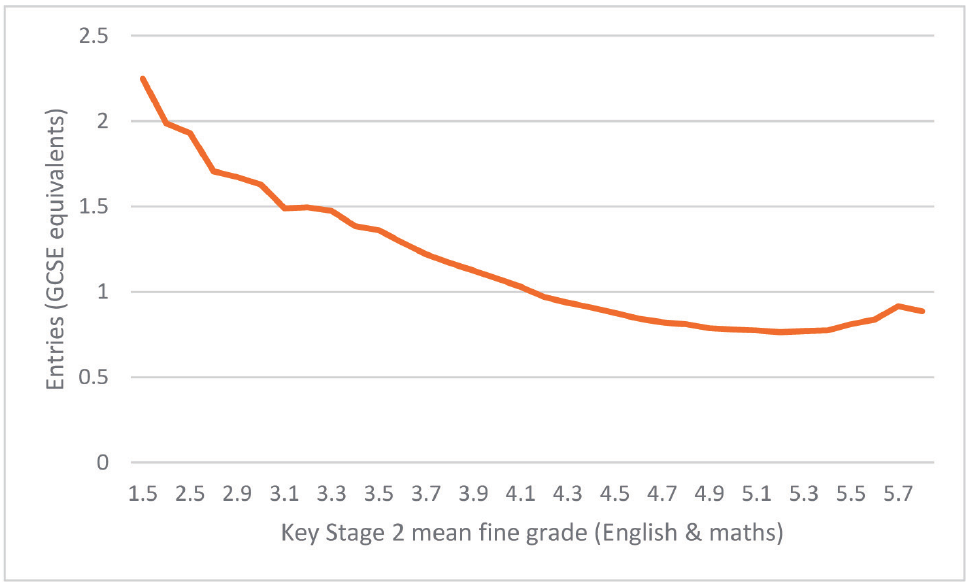
Figure 4: Mean number of entries (GCSE equivalents, old rules) in qualifications not counted in Performance Tables by prior attainment, pupils reaching the end of Key Stage 4 in maintained mainstream schools